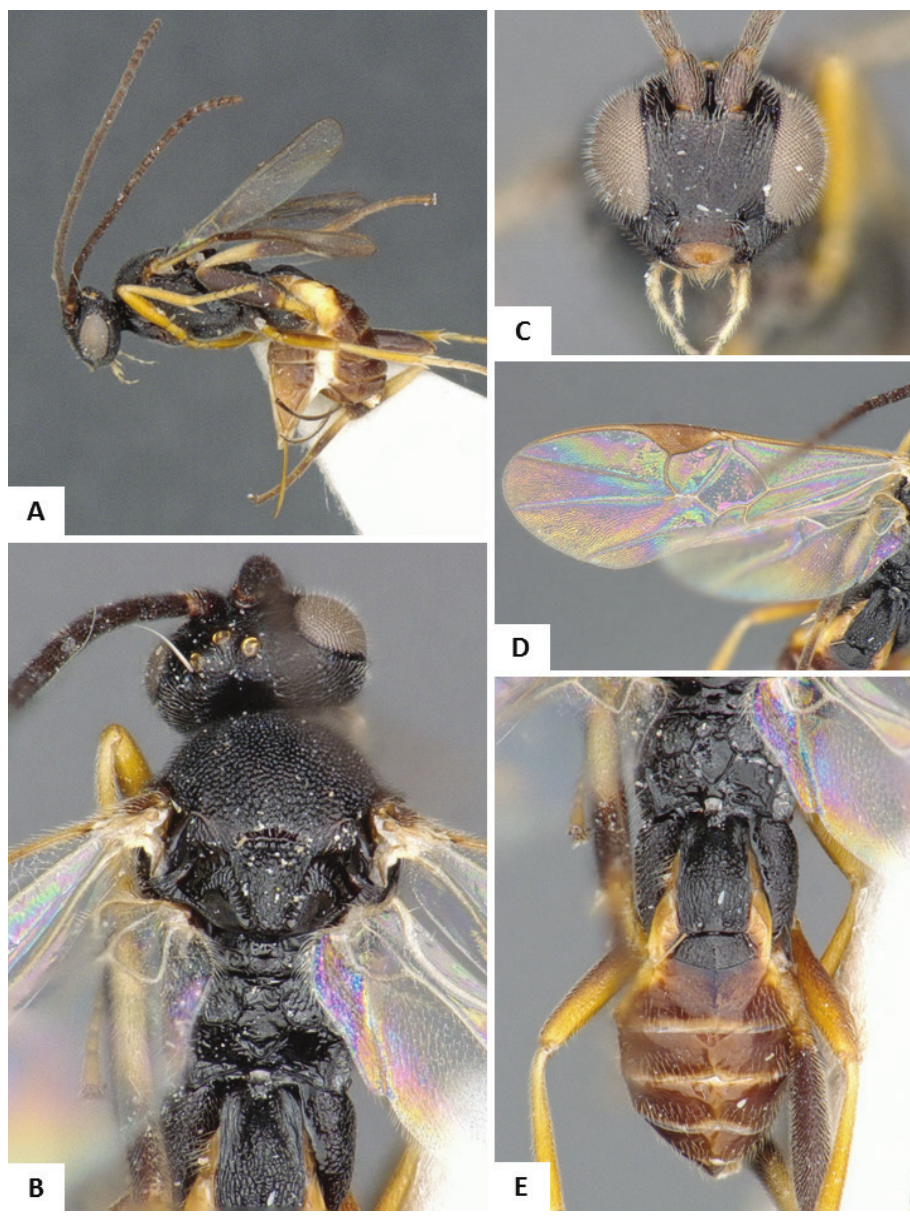
Figure 6. Apanteles hemara female specimen from Yemen (Voucher code: